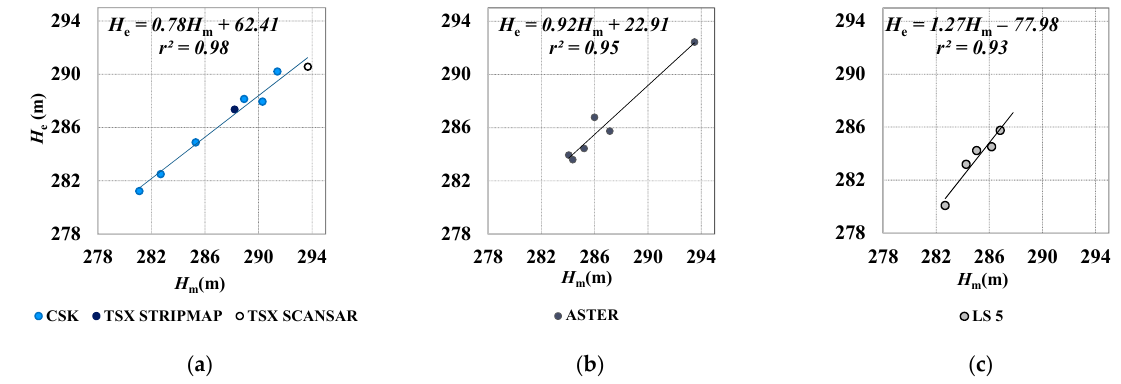
Figure 10. Water levels measured in situ ( H m ) vs. levels evaluated through classification ( H e ) using: ( a ) SAR; ( b ) ASTER; ( c ) LS5 data. The water level was derived from the specific surface-level relationship of the reservoir.